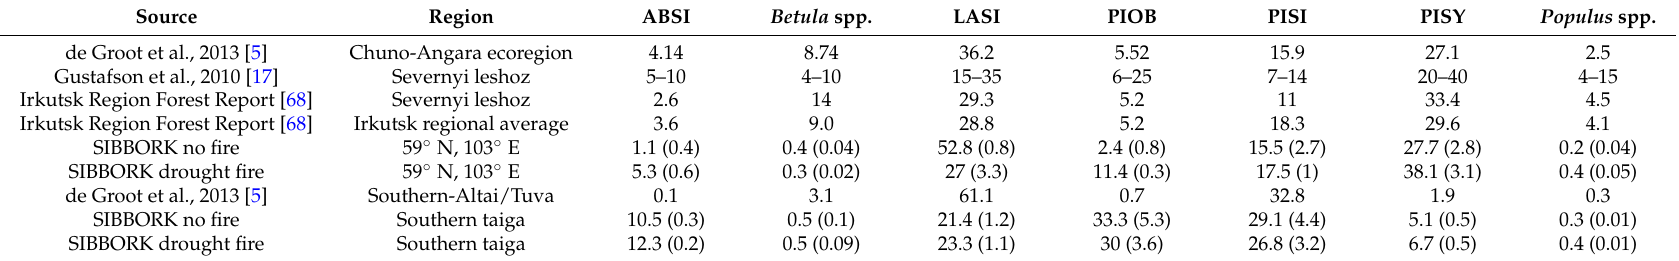
Table 5. The values are µ ( σ ) percent composition or a range. Values from the simulation are based on species contribution to total stand basal area.